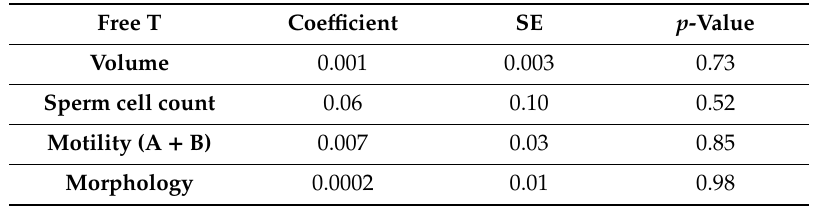
Table 4. Multivariable regression analysis for the e ff ect of free testosterone on semen parameters after adjustment for age, smoking status and